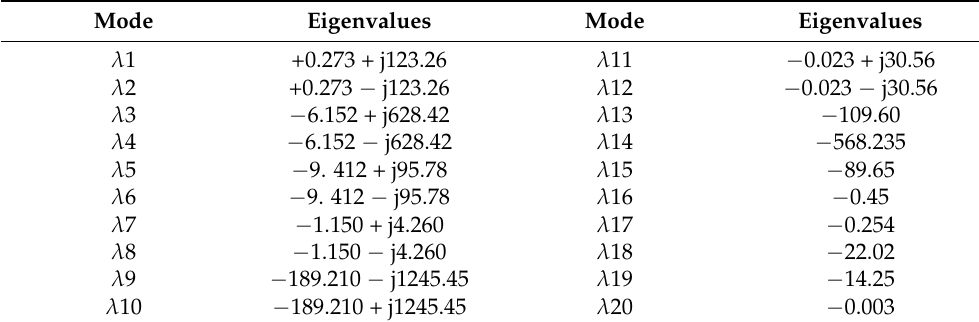
Table 2. Eigenvalues for compensation level 75% at wind speed 7